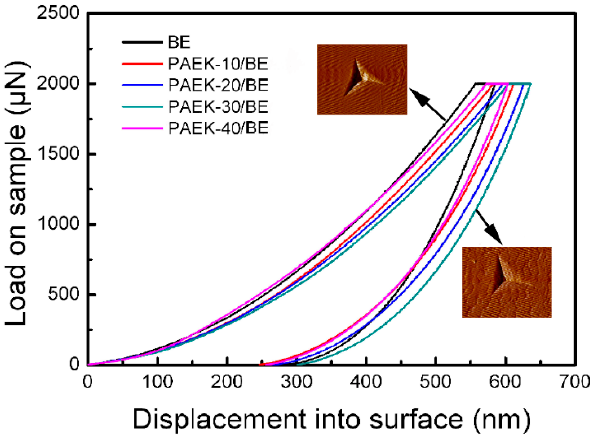
Figure 3. Typical load vs. displacement curves of the bicomponent high-performance epoxy resin and the composites.